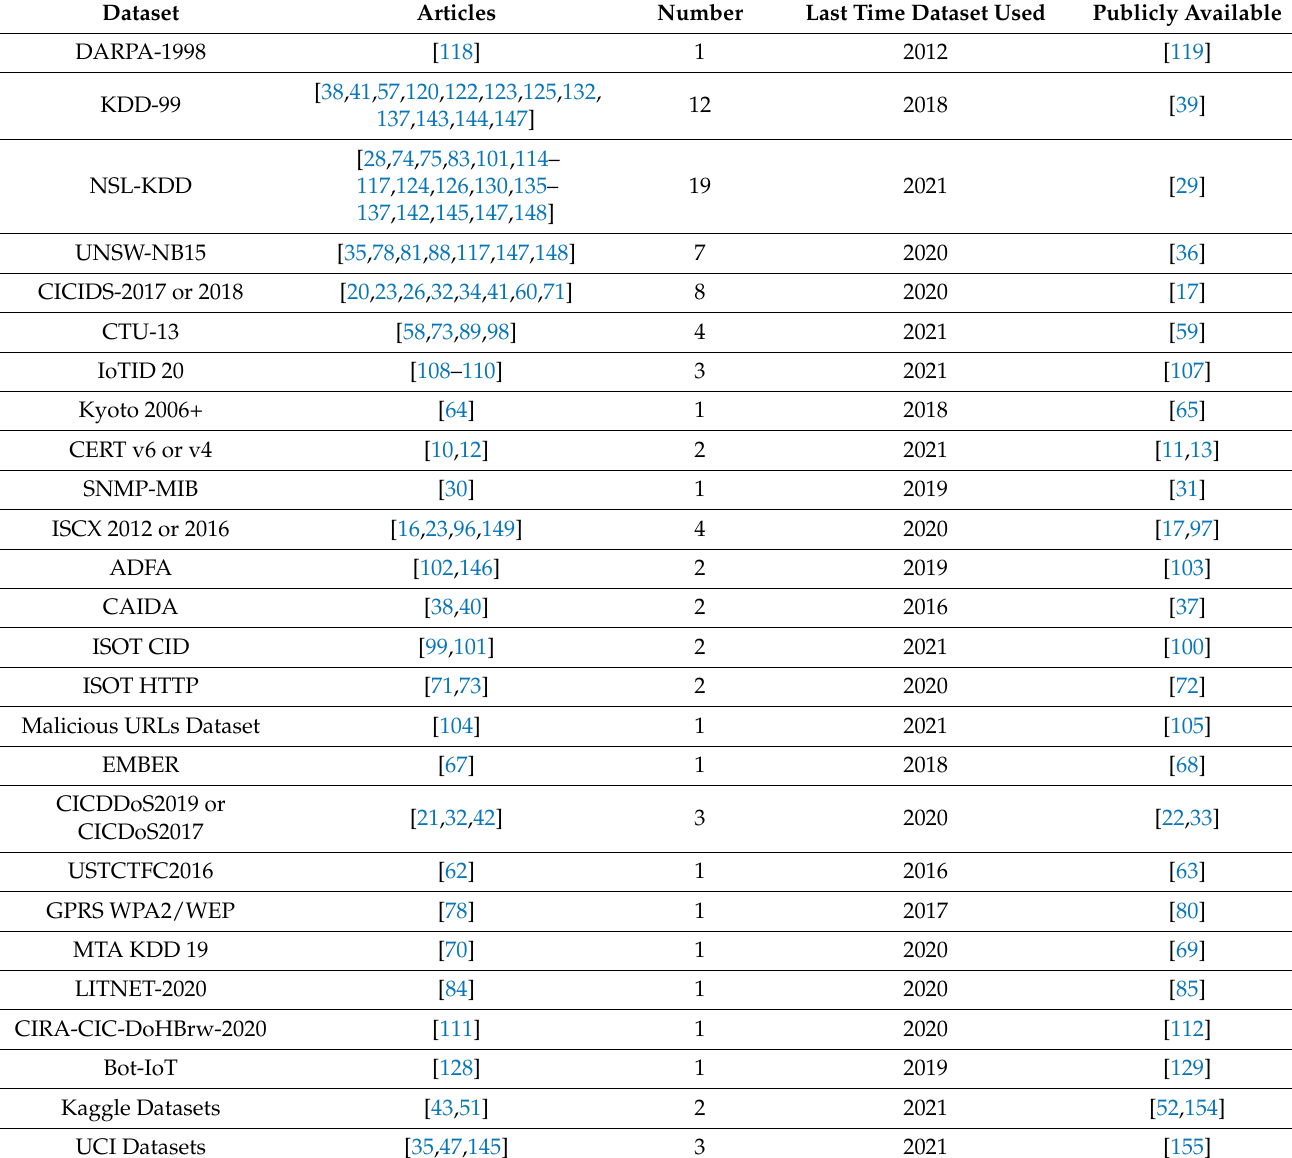
Table 4 lists all the respected papers that utilized the different datasets, highlighting the main references for all datasets as well as the last year when each dataset was used. Figure 2 presents the number of articles that utilized each dataset. Table 4. Network traffic datasets used in the reviewed